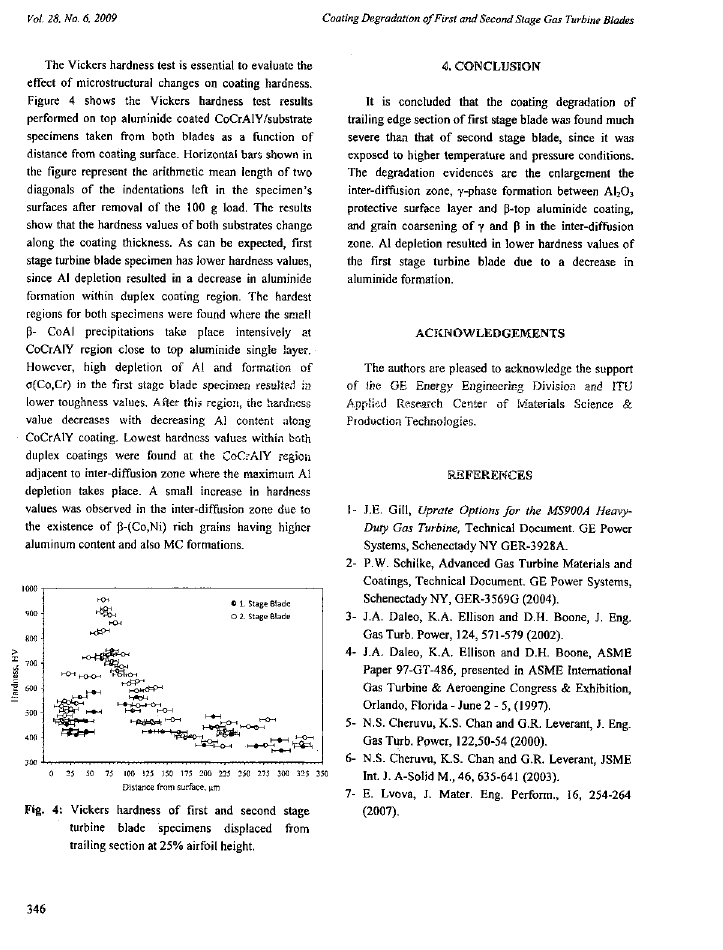
Fig. 4: Vickers hardness of first and second stage turbine blade specimens displaced from trailing section at 25% airfoil